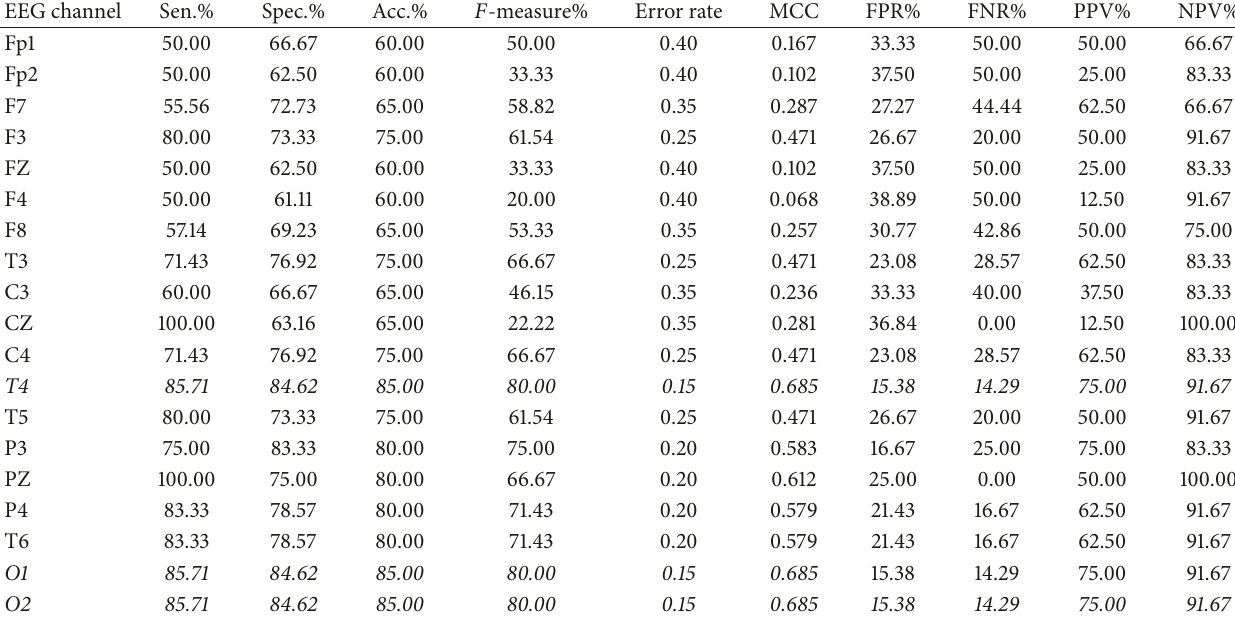
Table 2: TsEn performance for delta band of the EEG